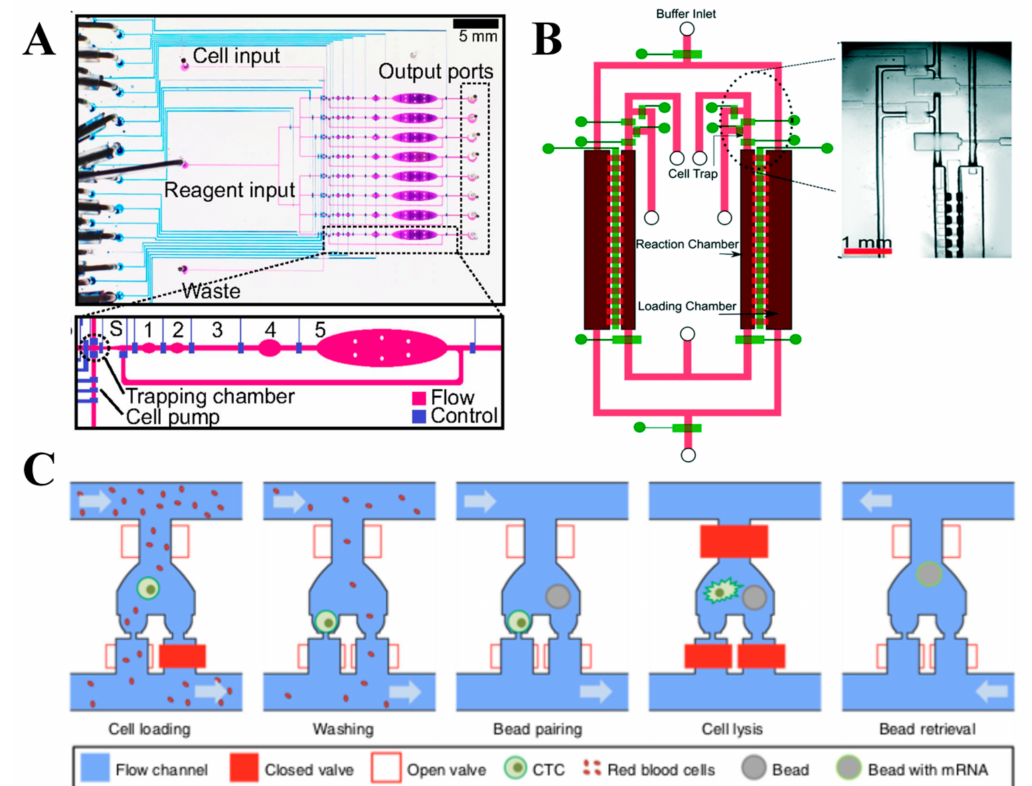
Figure 3. Valve-based scRNA-seq technologies. ( A ) A multilayer microfluidic device with integrated microvalves was developed to prepare cDNA from single cells for scRNA-seq with improved sensitivity and precision. Adapted with permission from Reference [19] © Creative Commons Attribution License (2014). ( B ) MID-RNA-seq technology consists of cell trap, bu ff er inlet, loading, and reaction chambers to trap and isolate single cells with a di ff usion-based reagent swapping scheme, which enables automation and multiplexing. Adapted with permission from Reference [51] © The Royal Society of Chemistry (2019). ( C ) Workflow of Hydro-seq that utilizes a sized-based single cell capture scheme to trap rare cells, such as circulating tumor cells (CTCs), while achieving > 70% cell capture e ffi ciency for downstream scRNA-seq. Adapted with permission from Reference [52] © Creative Commons Attribution License